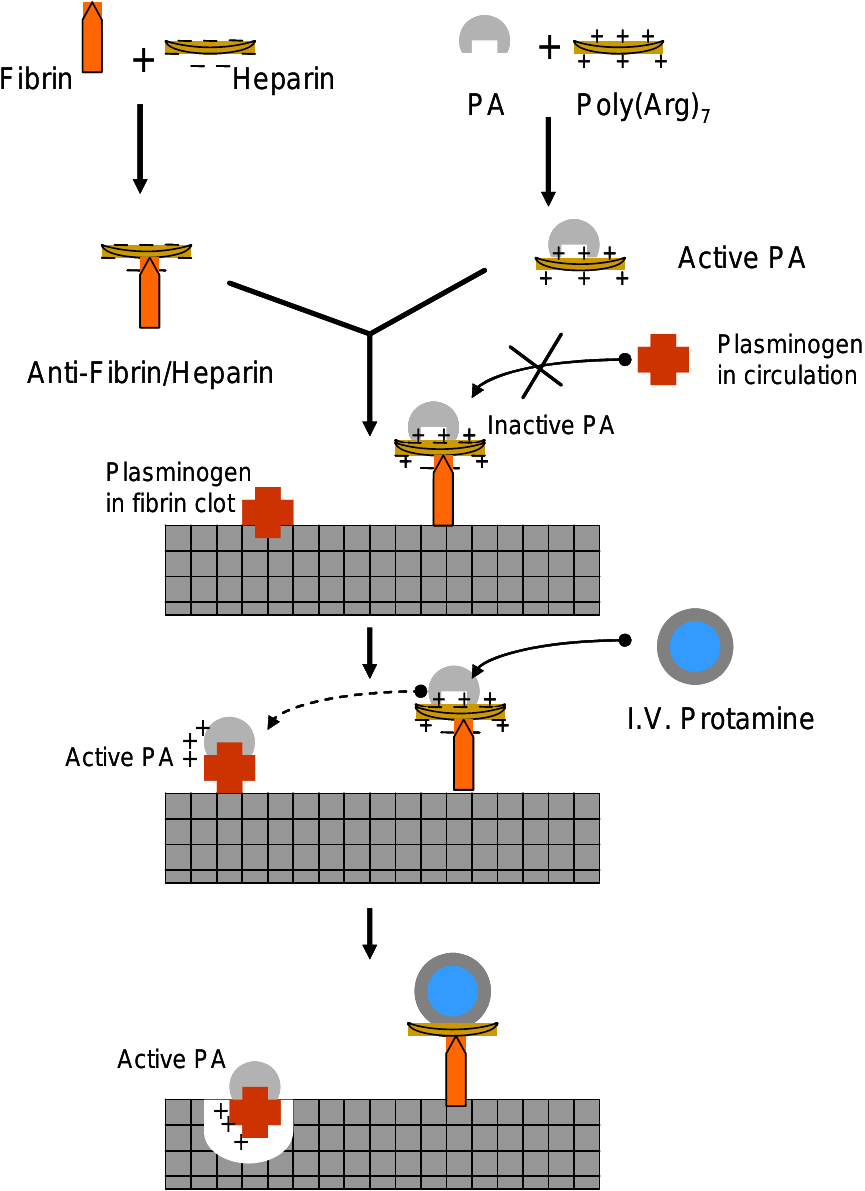
Figure 10. Schematic diagram of the ATTEMPTS approach (adapted from